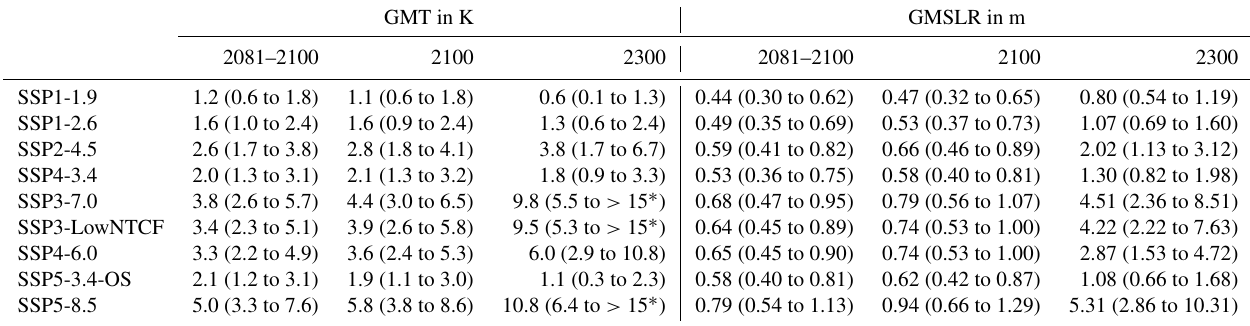
Table 7. SSP global mean surface air temperature (GMSAT) and global mean sea level rise (GMSLR) projections for the end of the 21st century (2081–2100 average and 2100 estimate) and 2300. GMSAT is shown in kelvin relative to 1750; GMSLR is shown in metres relative to the 1986–2005 average. Mean and 5th to 95th percentiles are provided for both